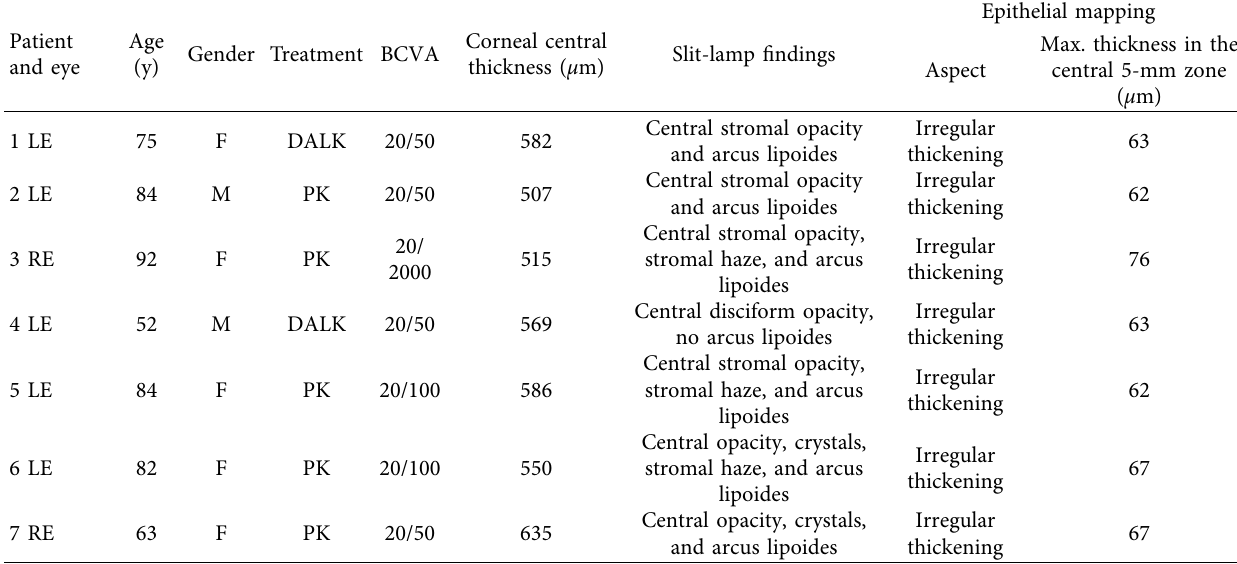
LE � left eye, RE � right eye, F � female, M � male, BCVA � best-corrected visual acuity, DALK � deep anterior lamellar keratoplasty, PK � penetrating